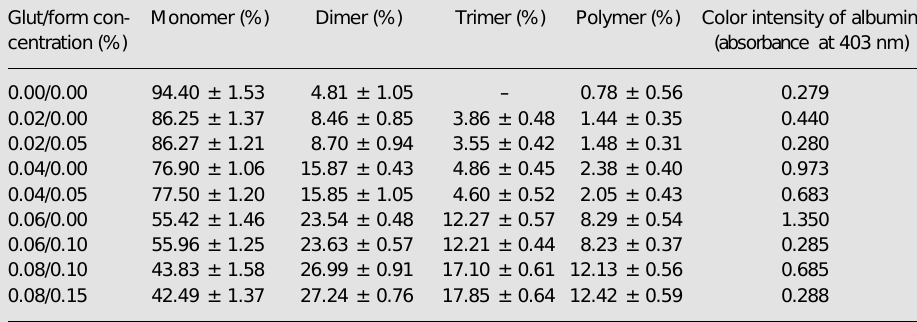
Table 3. Anti-Rho(D) titration using bovine albumin treated with glutaraldehyde/formaldehyde.